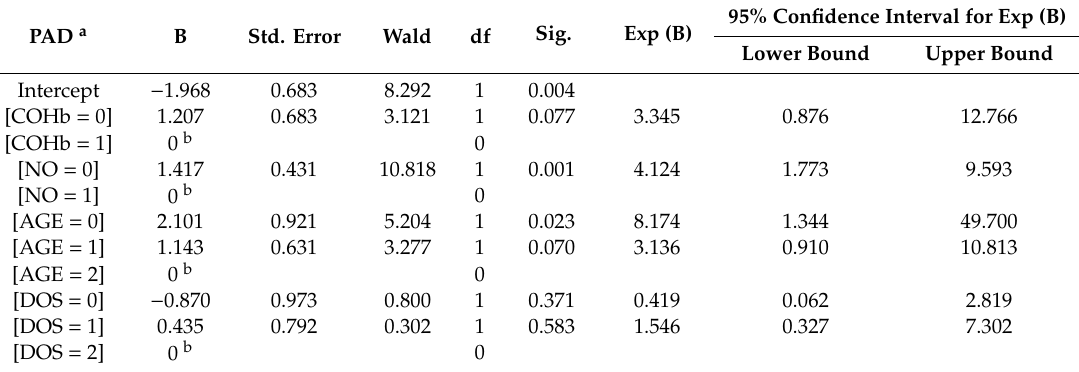
Table 4. Multivariate logistic regression analysis of factors that were associated with PAD during bivariate